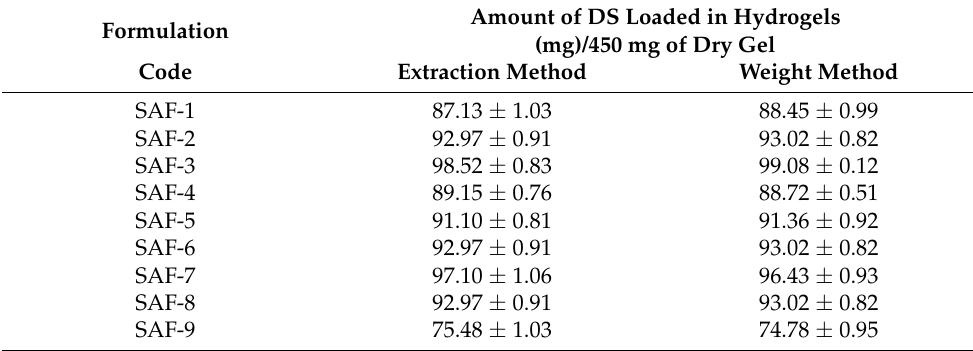
Table 1. Drug loading of SA-co-poly(AMPS)